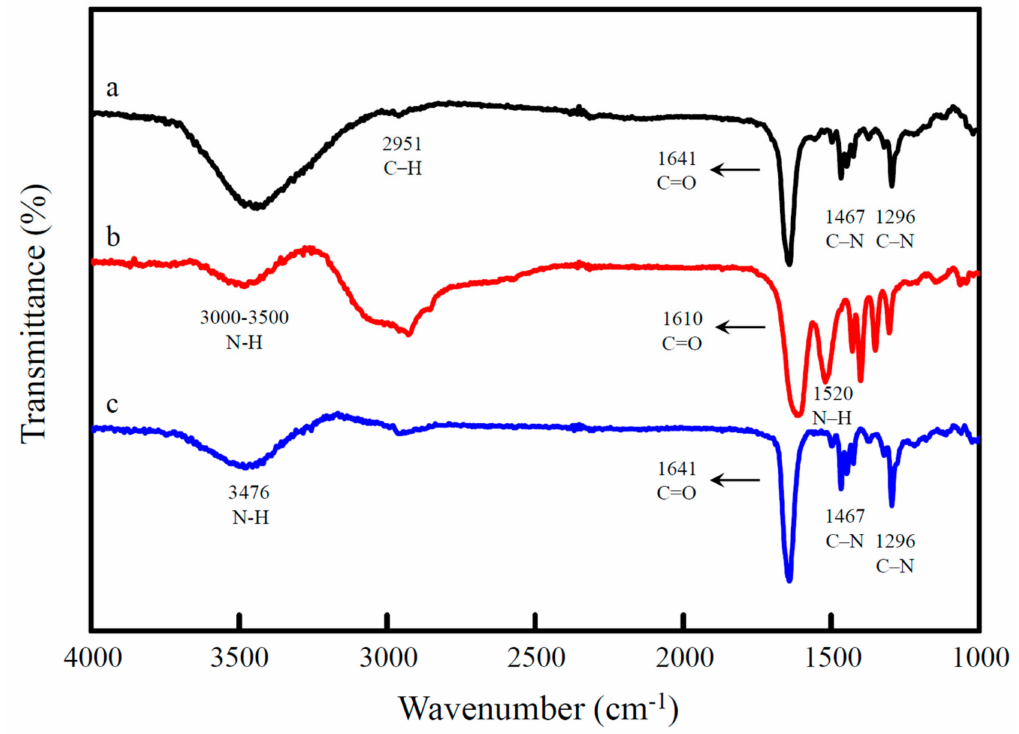
Figure 2. FTIR spectra of ( a ) poly(vinylpyrrolidone) (PVP), ( b ) L-Cysteine (CYS), and ( c ) the